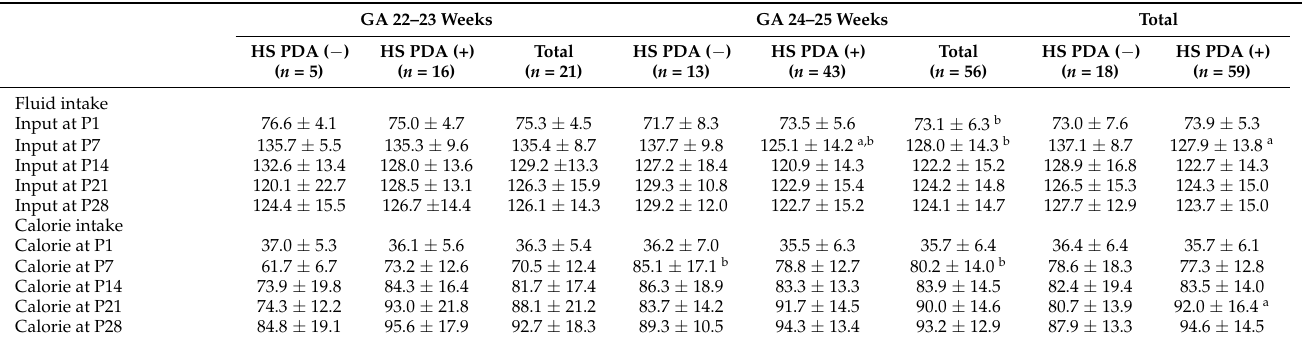
Table 3. Fluid and energy intake of the infants with or without HS PDA according to gestational